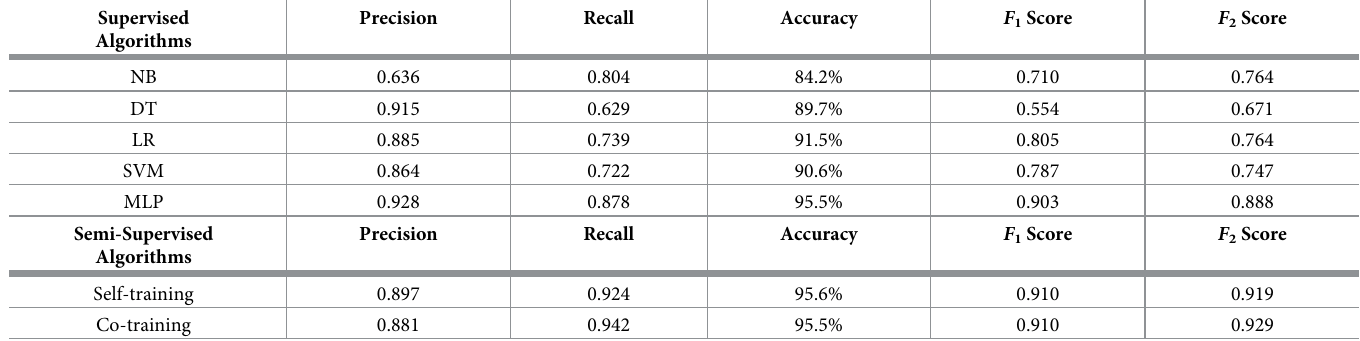
Table 7. Results of relevance classification on the test data. Naive Bayes (NB), Decision Tree (DT), Logistic Regression (LR), Support Vector Machine (SVM) and Multi- layer Perceptron (MLP) algorithms are reported together with the self-training and co-training iterative labelling algorithms. Supervised Algorithms